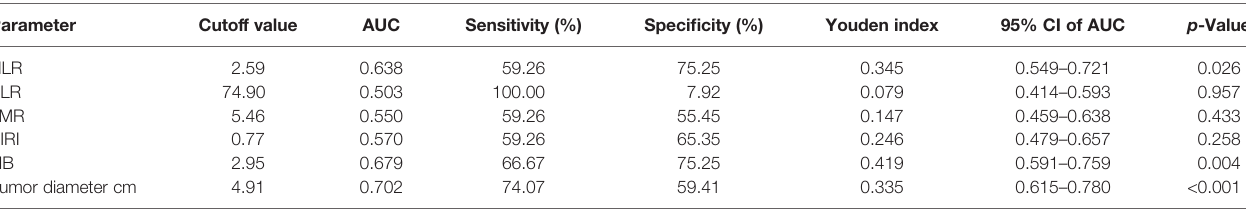
TABLE 2 | The cutoff value and area under the curve of the possible predictive factors of recurrence in training cohort. Parameter Cutoff value AUC